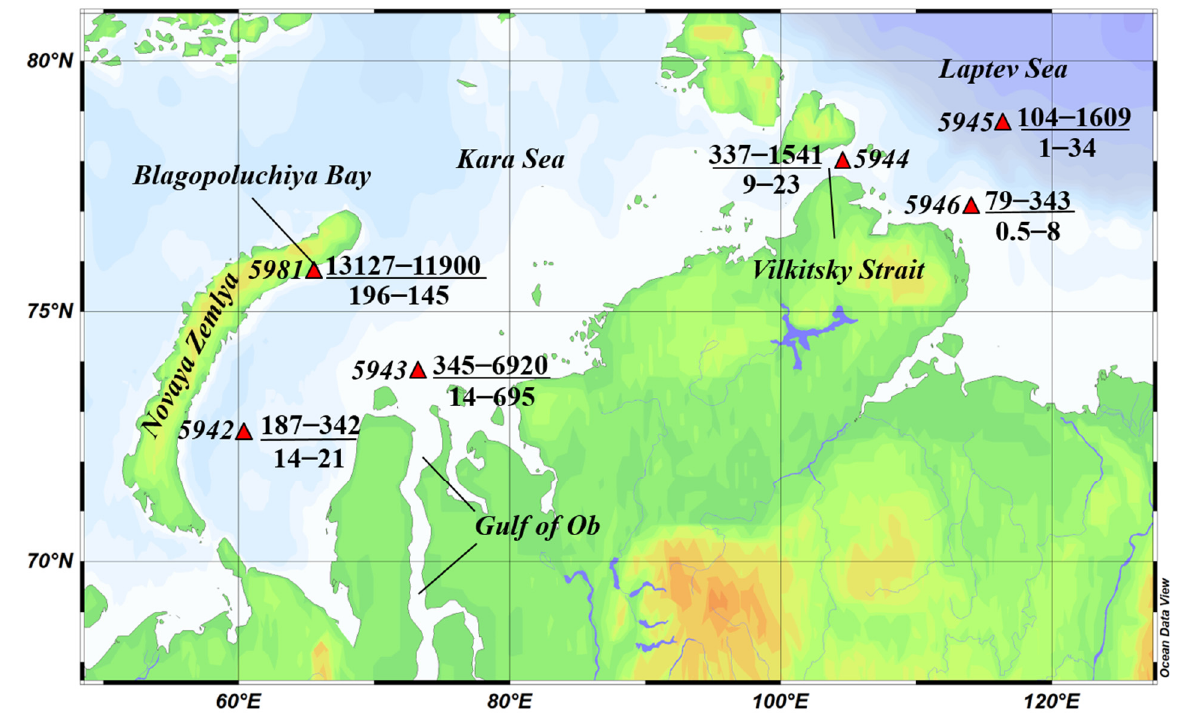
Figure 4. Flux variability “surface layer-depth layer” of particulate matter (mg/m 2 /day) (numerator) and organic carbon (mgC/m 2 /day) (denominator) obtained using sediment traps in the Kara and Laptev seas (triangles indicate location, italics indicate station numbers). Table 1. Results of studying the flux of suspended matter and C org in sediment